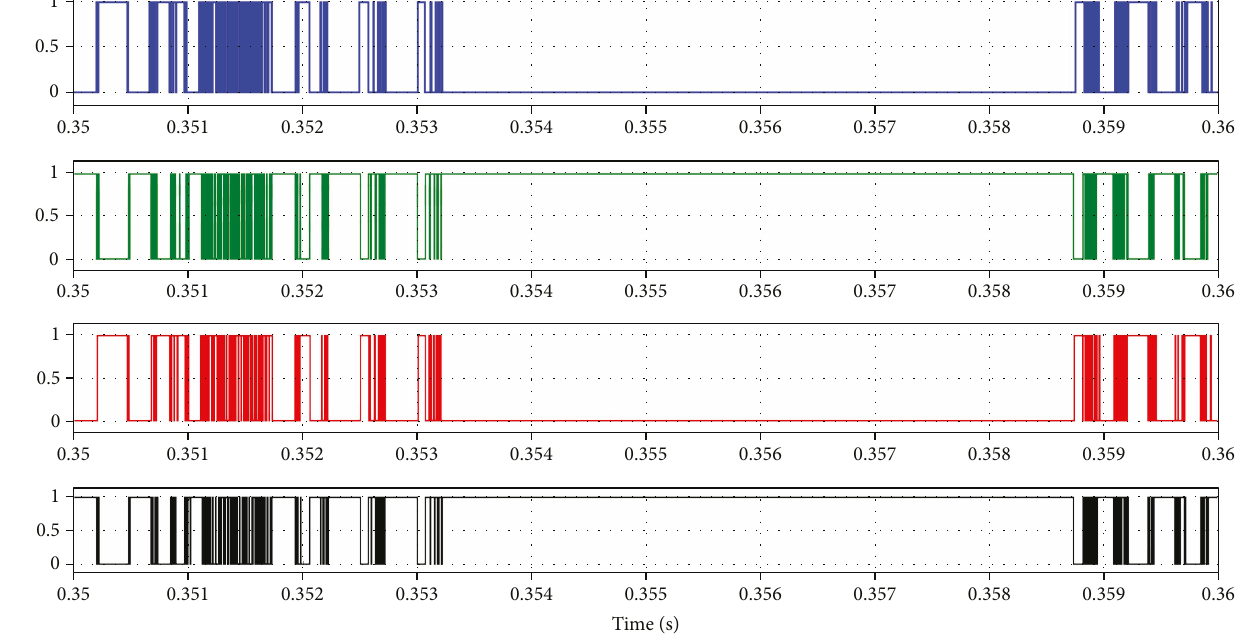
FFT window: 5 of 35.55 cycles of selected signal